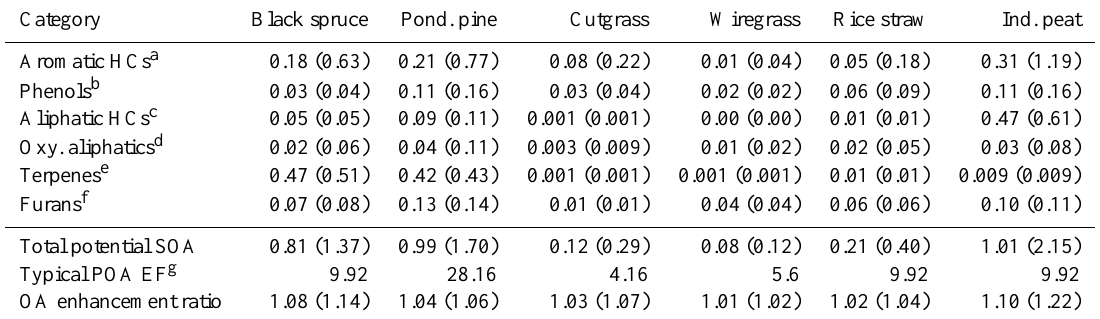
Assumed rate constants and SOA yields: a Benzene derivatives: k(OH) = 5.63 × 10 − 12 cm 3 molecule − 1 s − 1 (toluene; Atkinson and Arey, 2003a), SOA yield = 0.3 (Ng et al., 2007);